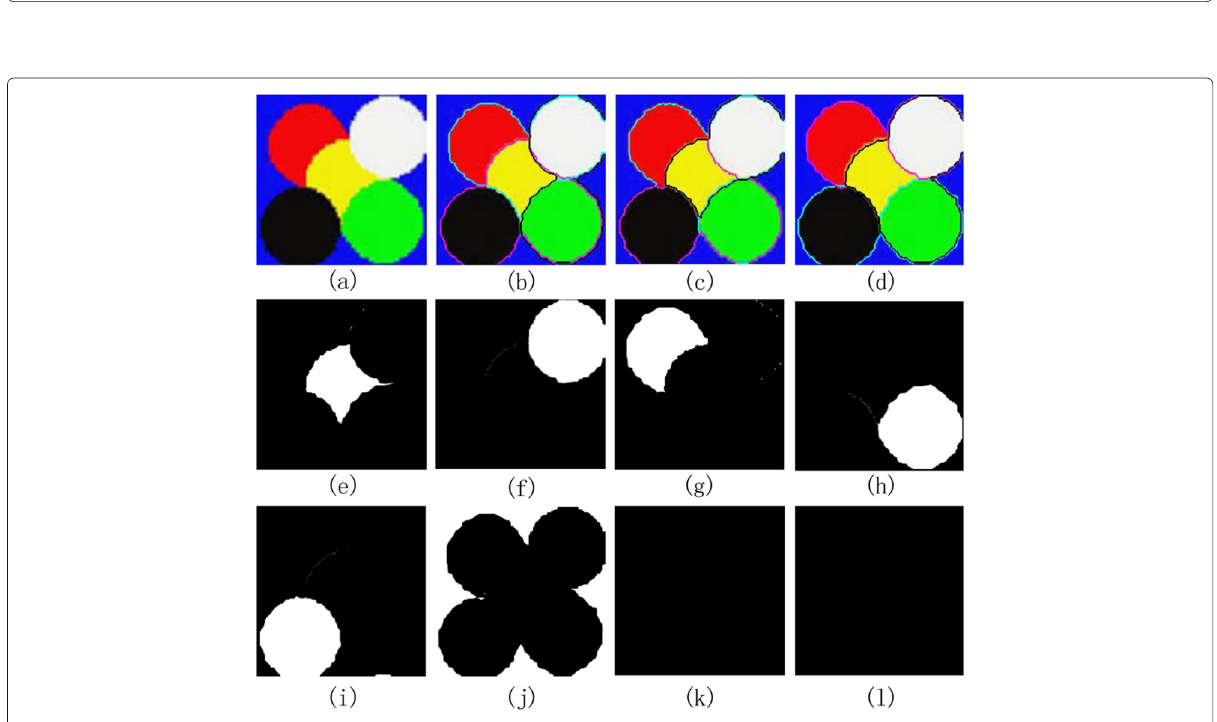
Fig. 10 Six-phase segmentation of a color image. a The input color synthetic image. b The segmentation of original Vese-Chan method. c The segmentation of TV regularization method. d The segmentation of our method. e – l Different regions obtained via our